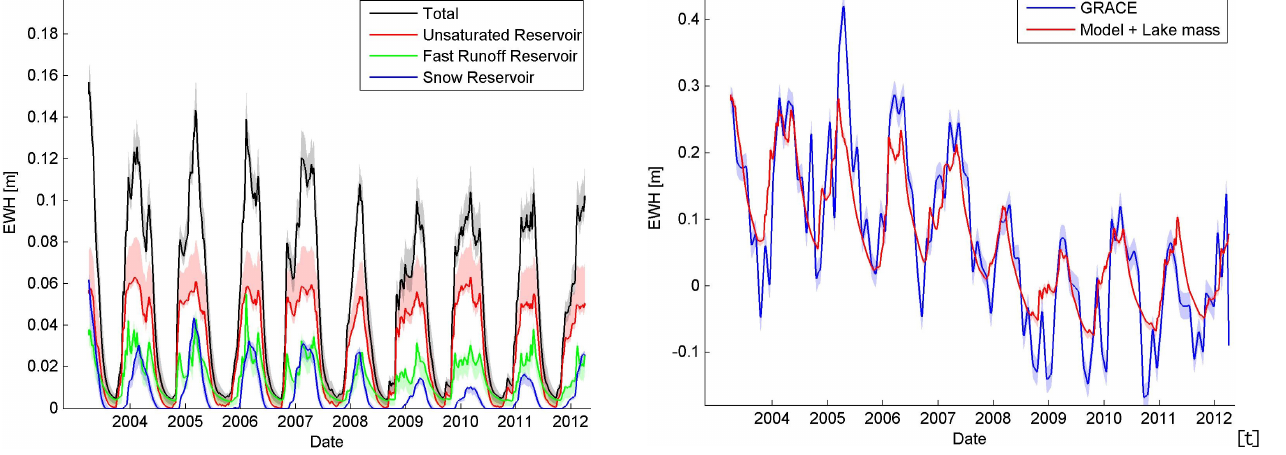
Figure 11. Water mass of the snow, unsaturated and fast runoff reservoir smoothed over 10days. Lines represent the optimal model and the bandwidth the Pareto ensemble based on NS and log NS of streamflow.